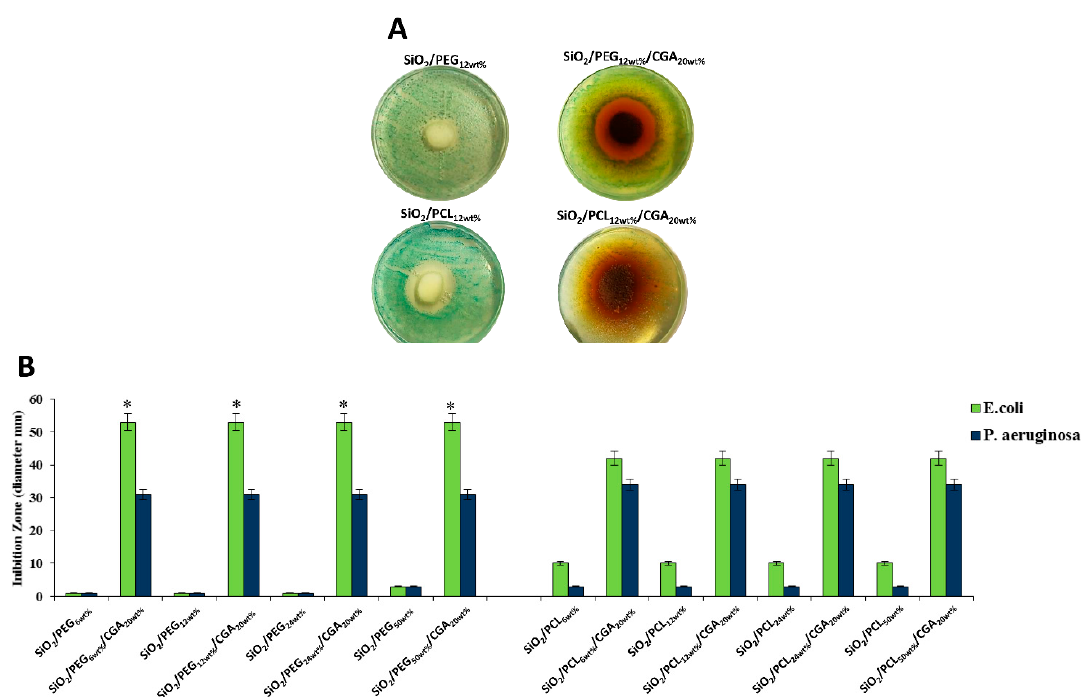
Figure 8. ( A ) Representative inhibition halo (ID) of E. coli with SiO 2 /PEG 12 wt % , SiO 2 /PEG 12 wt % /CGA 20 wt % , SiO 2 /PCL 12 wt % , and SiO 2 /PCL 12 wt % /CGA 20 wt % ; ( B ) The diameter (mm) of inhibition zone of all materials. Values are the mean SD of measurements carried out on samples analyzed three times. The means and SD are shown. * p < 0.05 vs. the bacteria control treated with hybrids without CGA or vs. the bacteria treated with hybrids containing CGA.